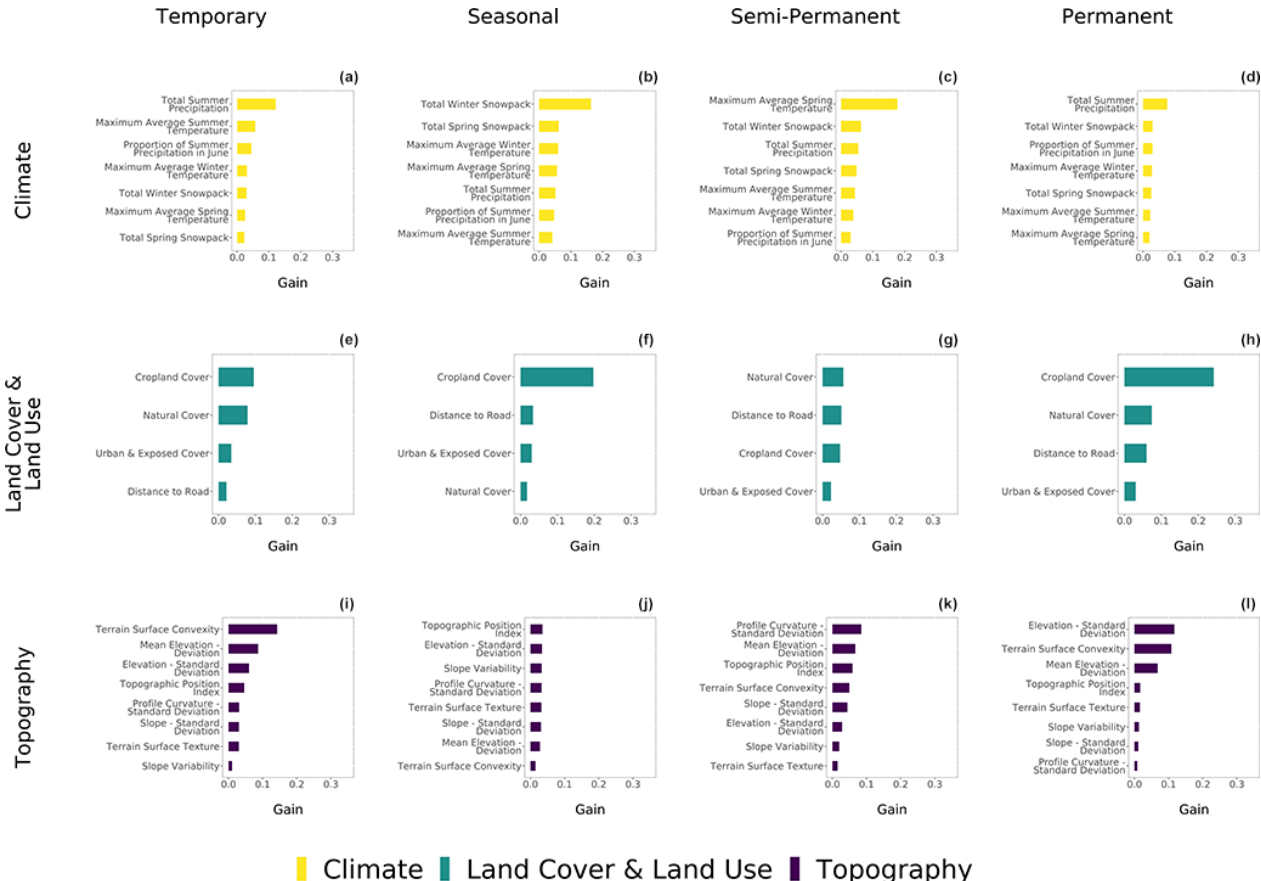
Figure E1. Variables ranked by their importance in the extreme gradient boosting models for wetlands delineated in the Boreal Forest (to- talling 12000 wetlands) by permanence class. These variables were proxies for climate (a–d) , land cover and land use (e–h) , and topography roughness (i–l) . The gains illustrate the relative contribution of each variable in the model – the higher the value, the greater the